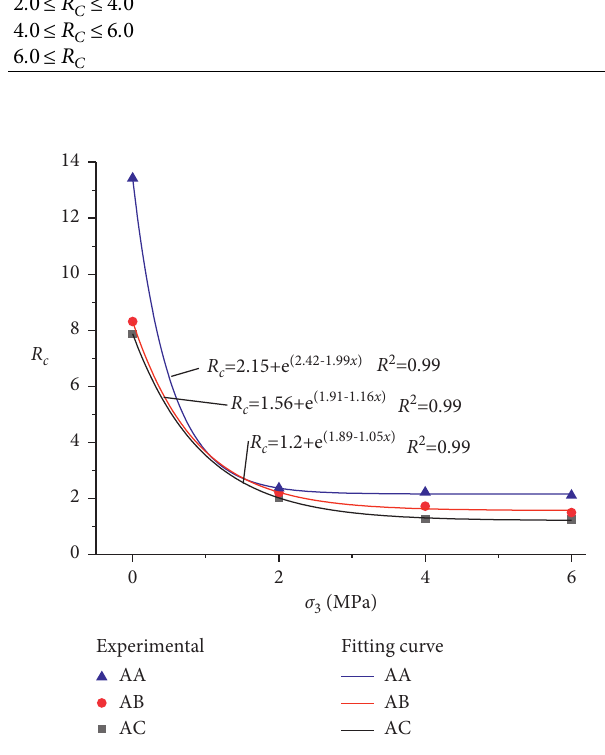
Figure 10: Relationship between the anisotropy ratio and the confining